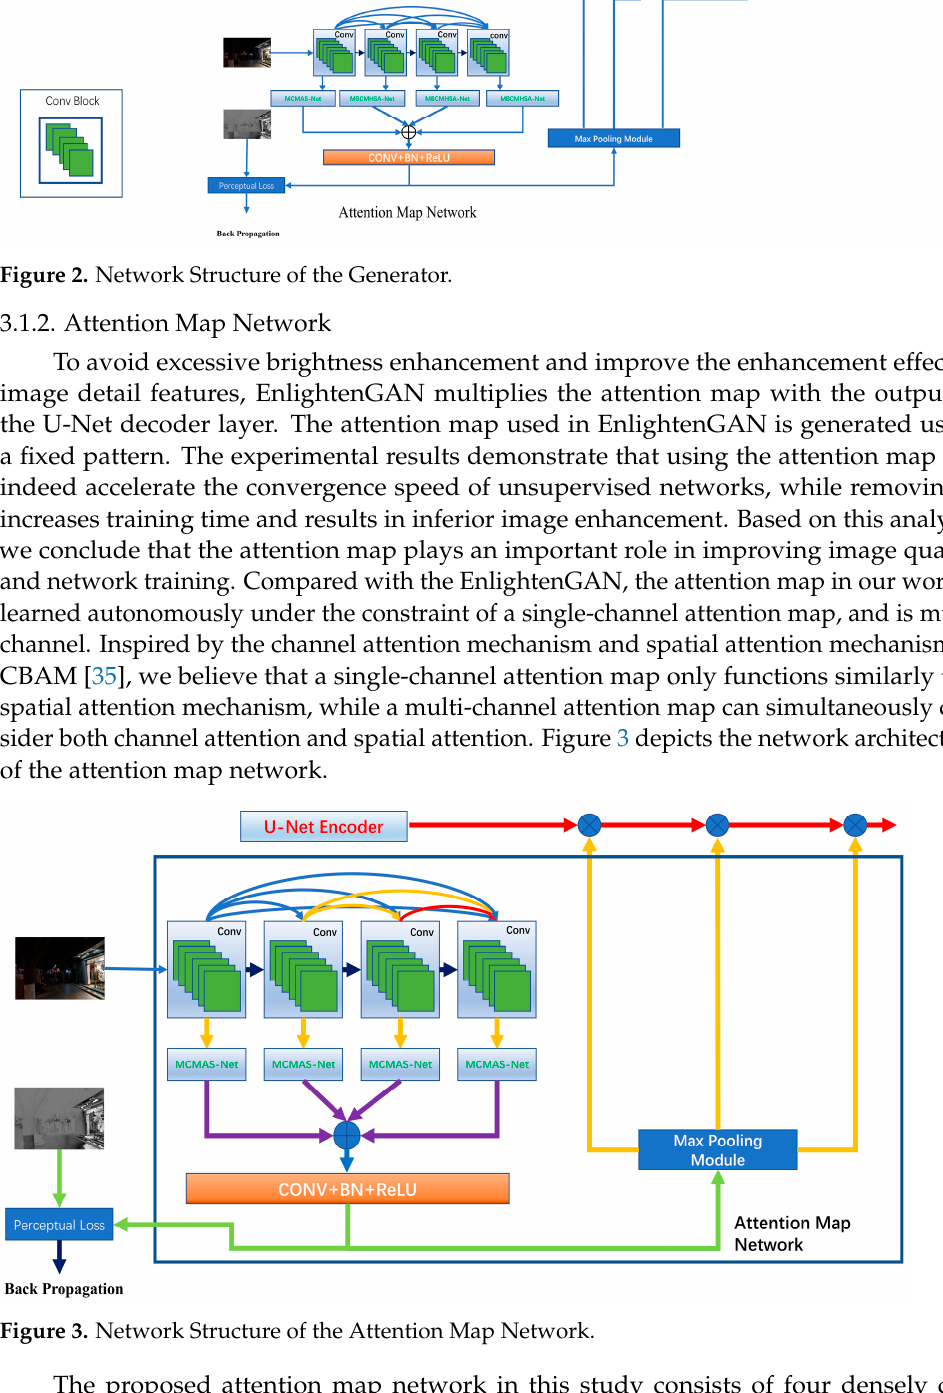
Figure 4. Network Structure of the Max Pooling Module. 3.1.3. Multi-Branch Convolutional Multi-Head Self-Attention Network In deep learning networks, attention-based network or modules can improve image quality by assigning higher weights to important regions of the image. Additionally, in convolutional neural networks, the size of the convolutional kernel can affect the scale of the extracted features. Smaller kernels can capture more detailed features, while larger kernels can capture coarser features. For example, 1 × 1 kernels can be used for inter- channel information interaction, 3 × 3 kernels can capture local features, and 5 × 5 or larger kernels can capture larger or global features. Based on these ideas, we propose a network that integrates multi-branch convolution and multi-head self-attention mecha- nisms, which we refer to as the Multi-Branch Convolution Multi-Head Self-Attention (MHSA) [36,37] Network (MBCMHSA-Net). This network is highly flexible and can be embedded into various branches of the main network. The structure of MBCMHSA-Net is shown in Figure 5.